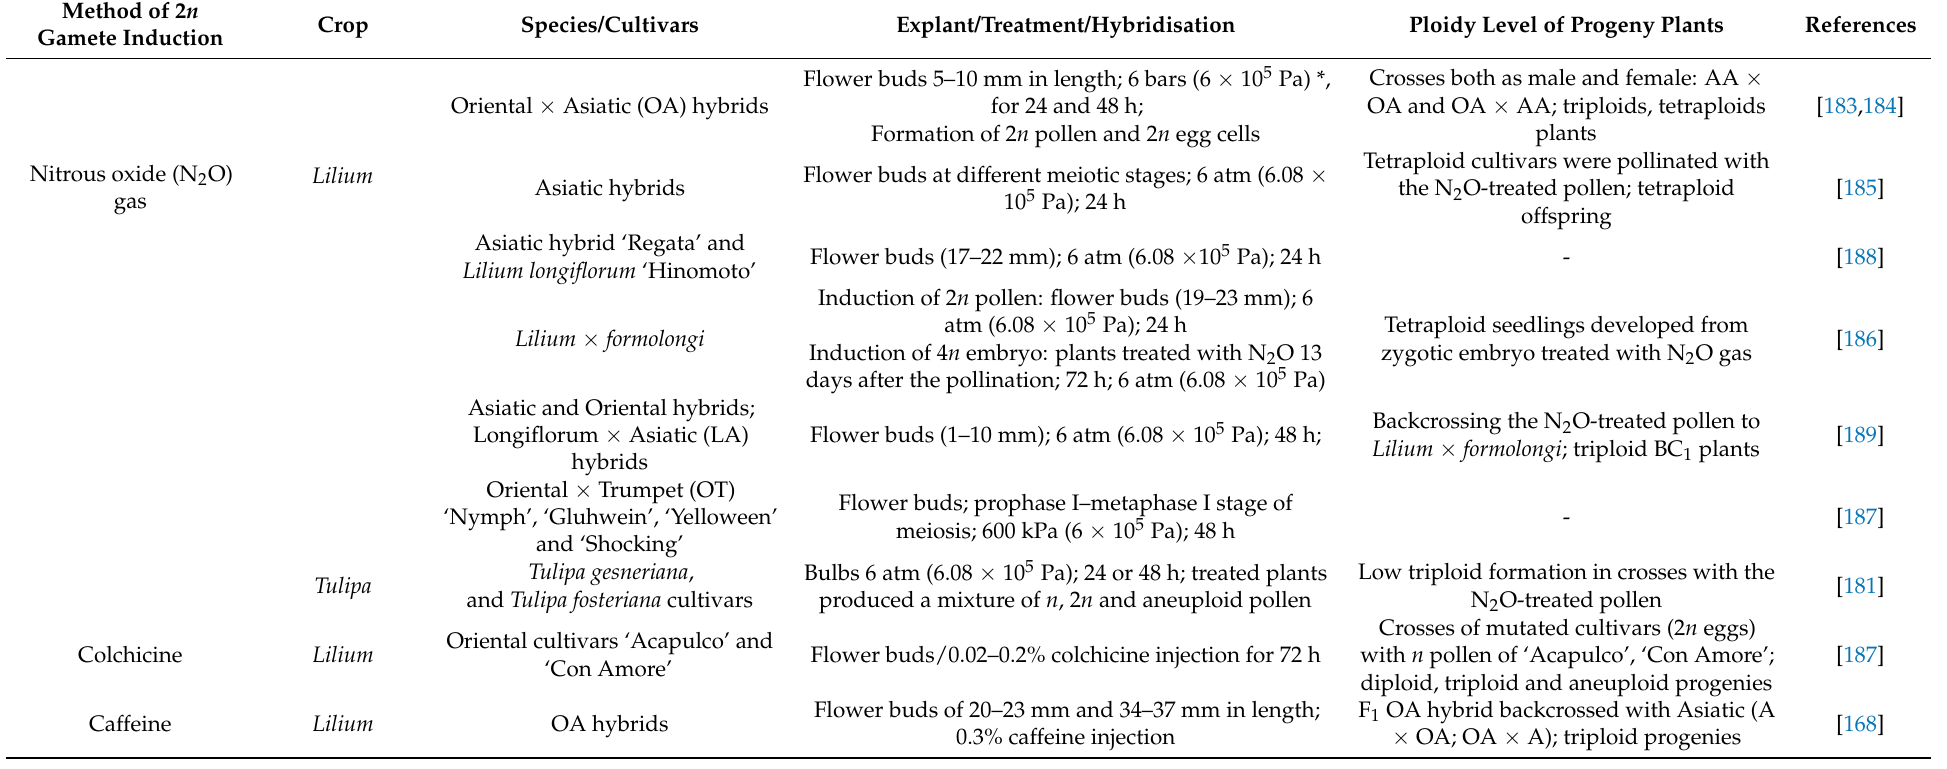
Table 1. Reports on the inducing factor of unreduced gamete formation and their application for meiotic polyploidisation in selected ornamental bulbous